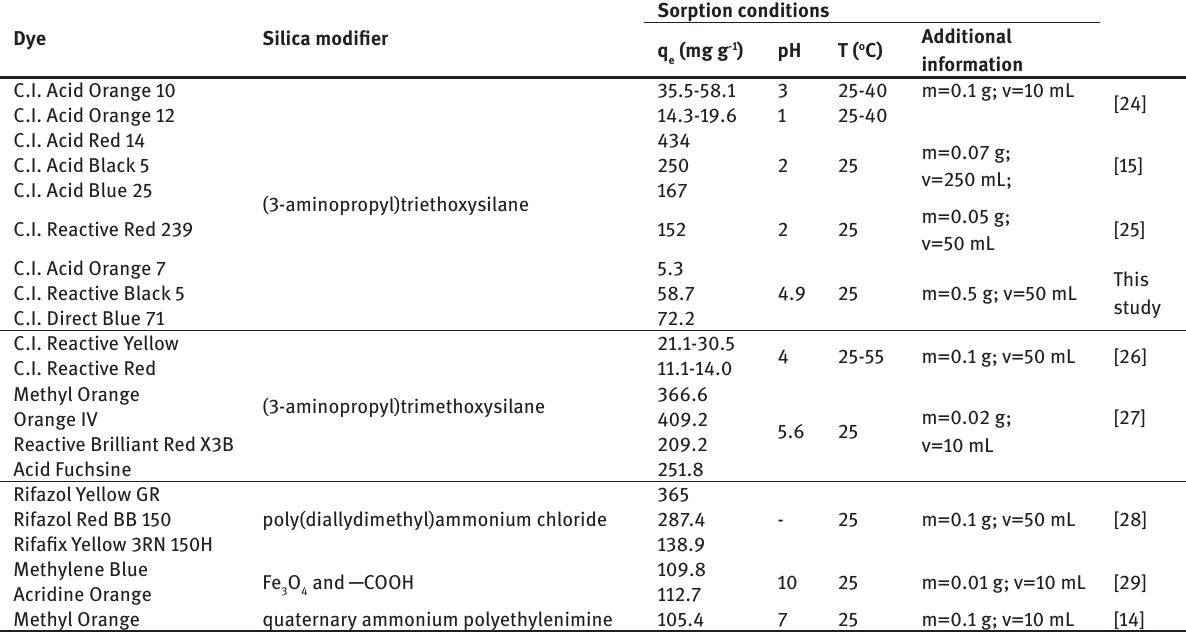
Table 6: Comparison of acid, reactive and direct dyes uptake by silica type adsorbents.